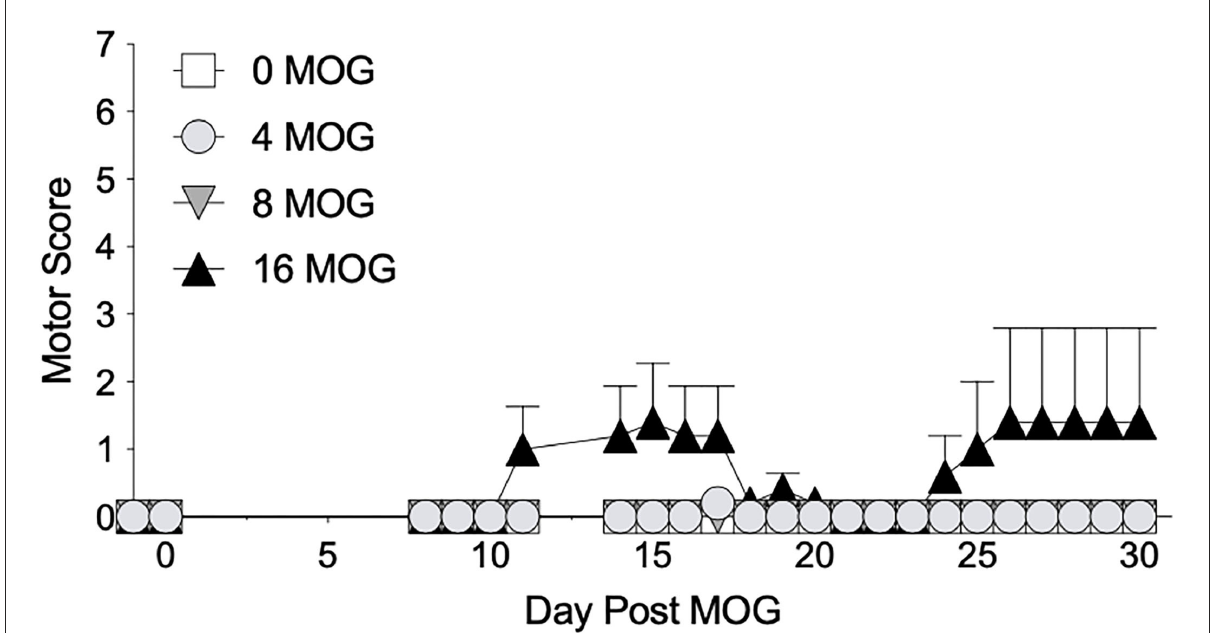
FIGURE1 Myelin oligodendrocyte glycoprotein (MOG) in Sprague-Dawley (SD) rats produces no motor scores at low doses and mild motor scores a higher doses. Sprague-Dawley (SD) rats were baselined (BL) for motor scores followed by intradermal low-dose (0, 4, 8, and 16 µ g) myelin oligodendrocyte glycoprotein (MOG). Motor scores were assessed thereafter across the timecourse shown, continuing through day 30. Neither 4 or 8 µ g MOG produced motor scores, whereas 16 µ g MOG produced mild motor scores. No dose of MOG reliably increased motor scores. N =